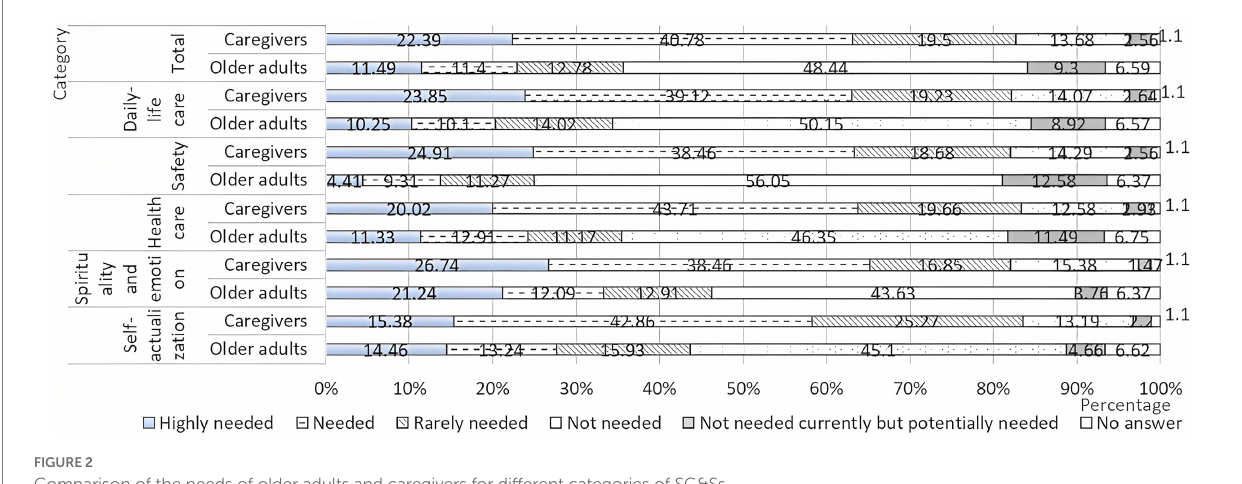
FIGURE 2 Comparison of the needs of older adults and caregivers for different categories of